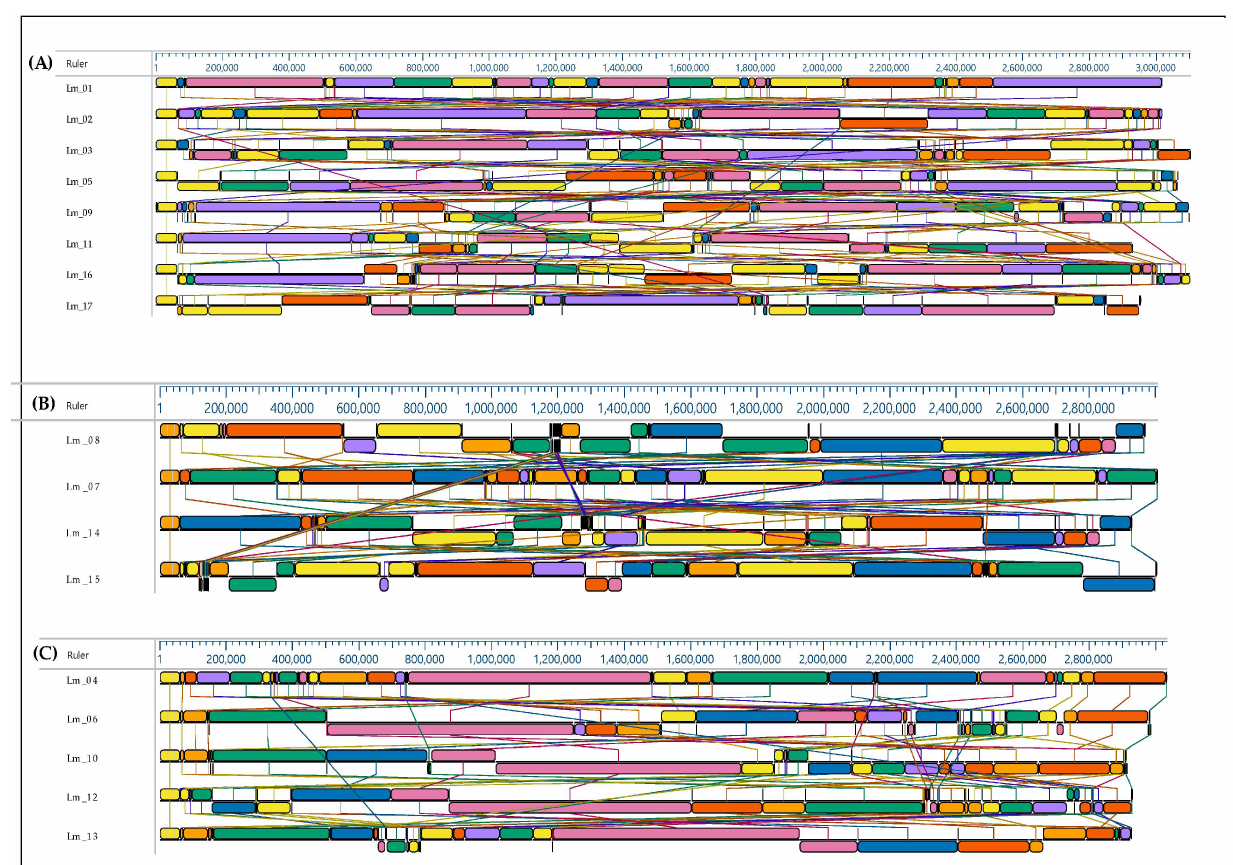
Figure 8. Collinearity analysis of the L. monocytogenes genomes isolated from smoked salmon ( A ), raw salmon ( B ) and food environment ( C ). Local collinear blocks are represented by blocks of the same color connected by